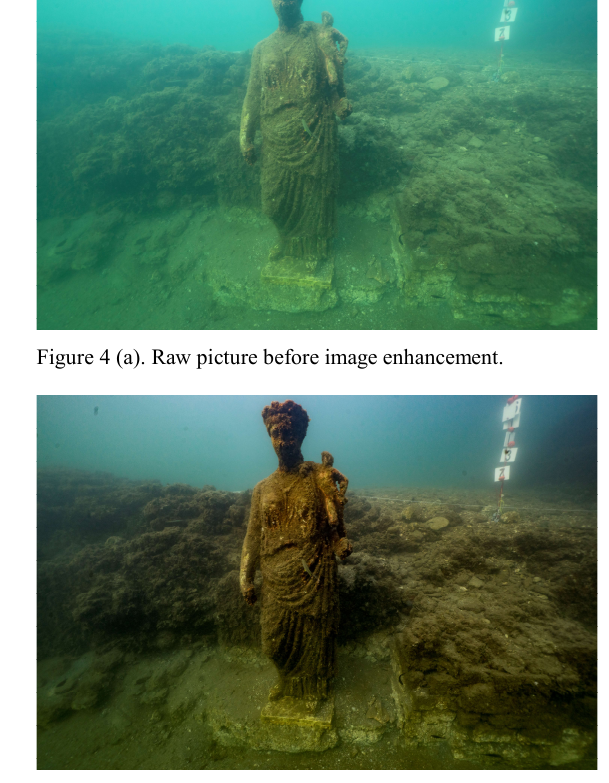
Figure 4 (b). Picture enhanced with algorithms described in (Mangeruga et al.,